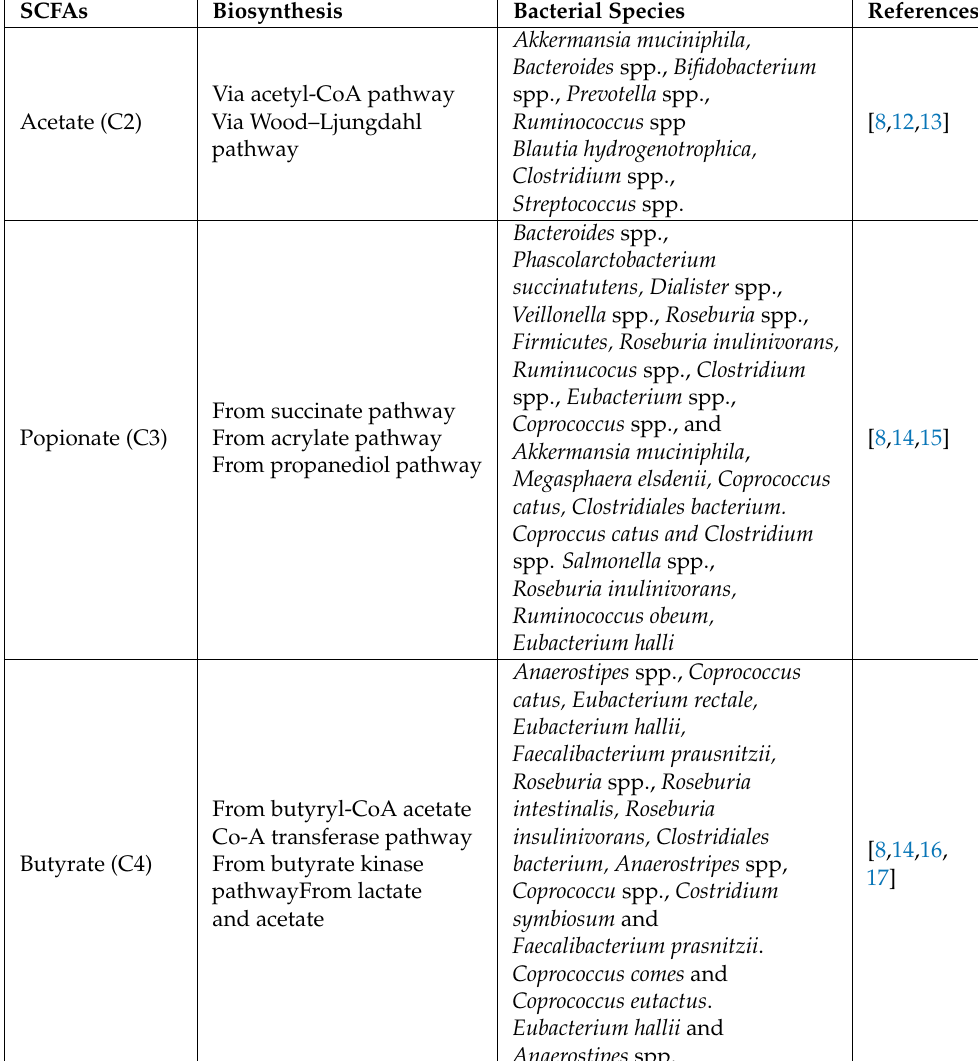
Table 1. Gut microbiota species and short-chain fatty